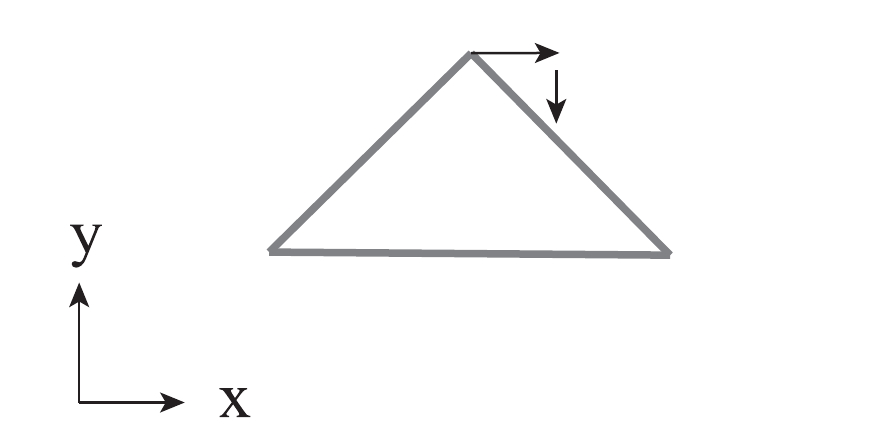
Fig 5. An example of the positive directions for each axis in each condition from a top view (rightward